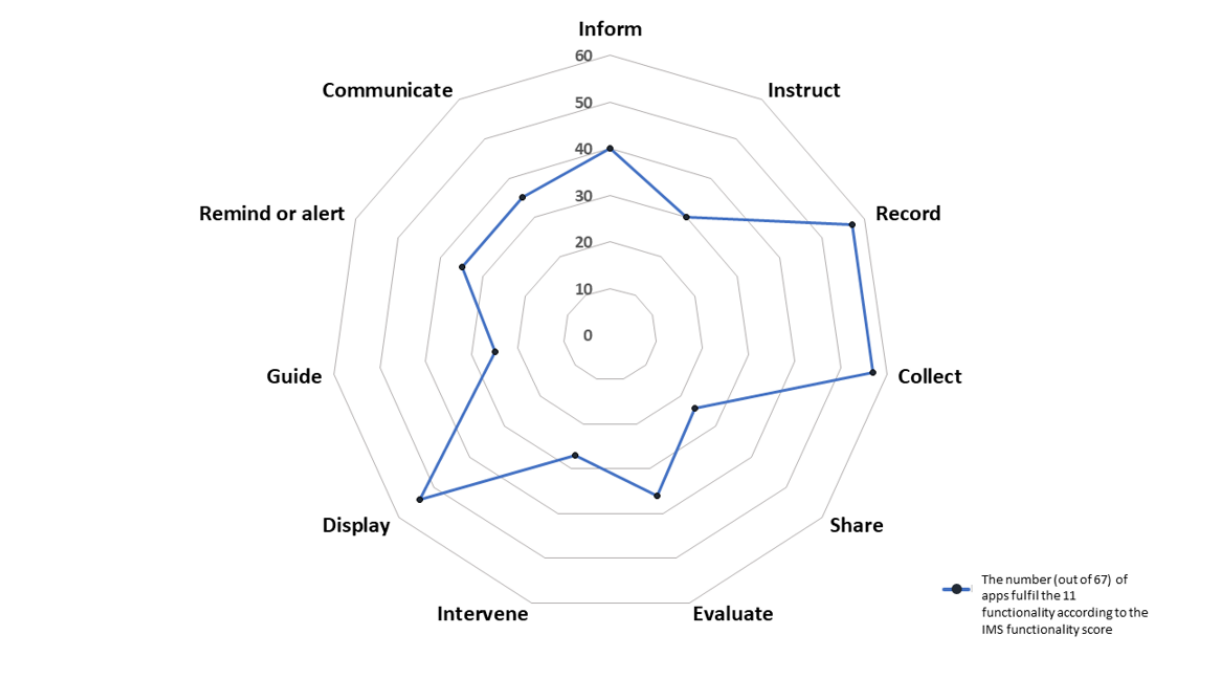
Figure 3. Number of apps that meet the functionality